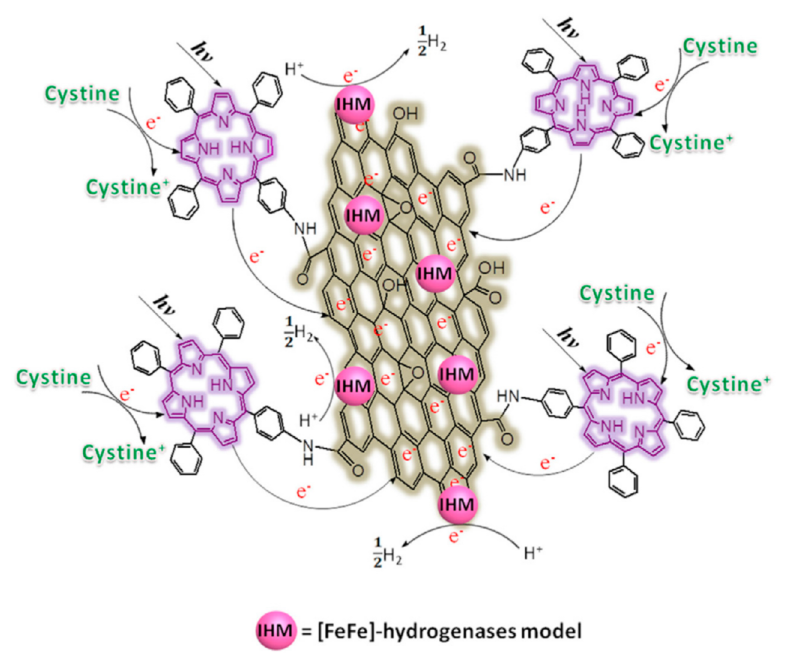
Figure 21. The proposed mechanism of photocatalytic H 2 production for a catalytic system based on GO, a porphyrin sensitizer and a biomimetic catalyst. Reproduced from [129] with the permission of Elsevier.